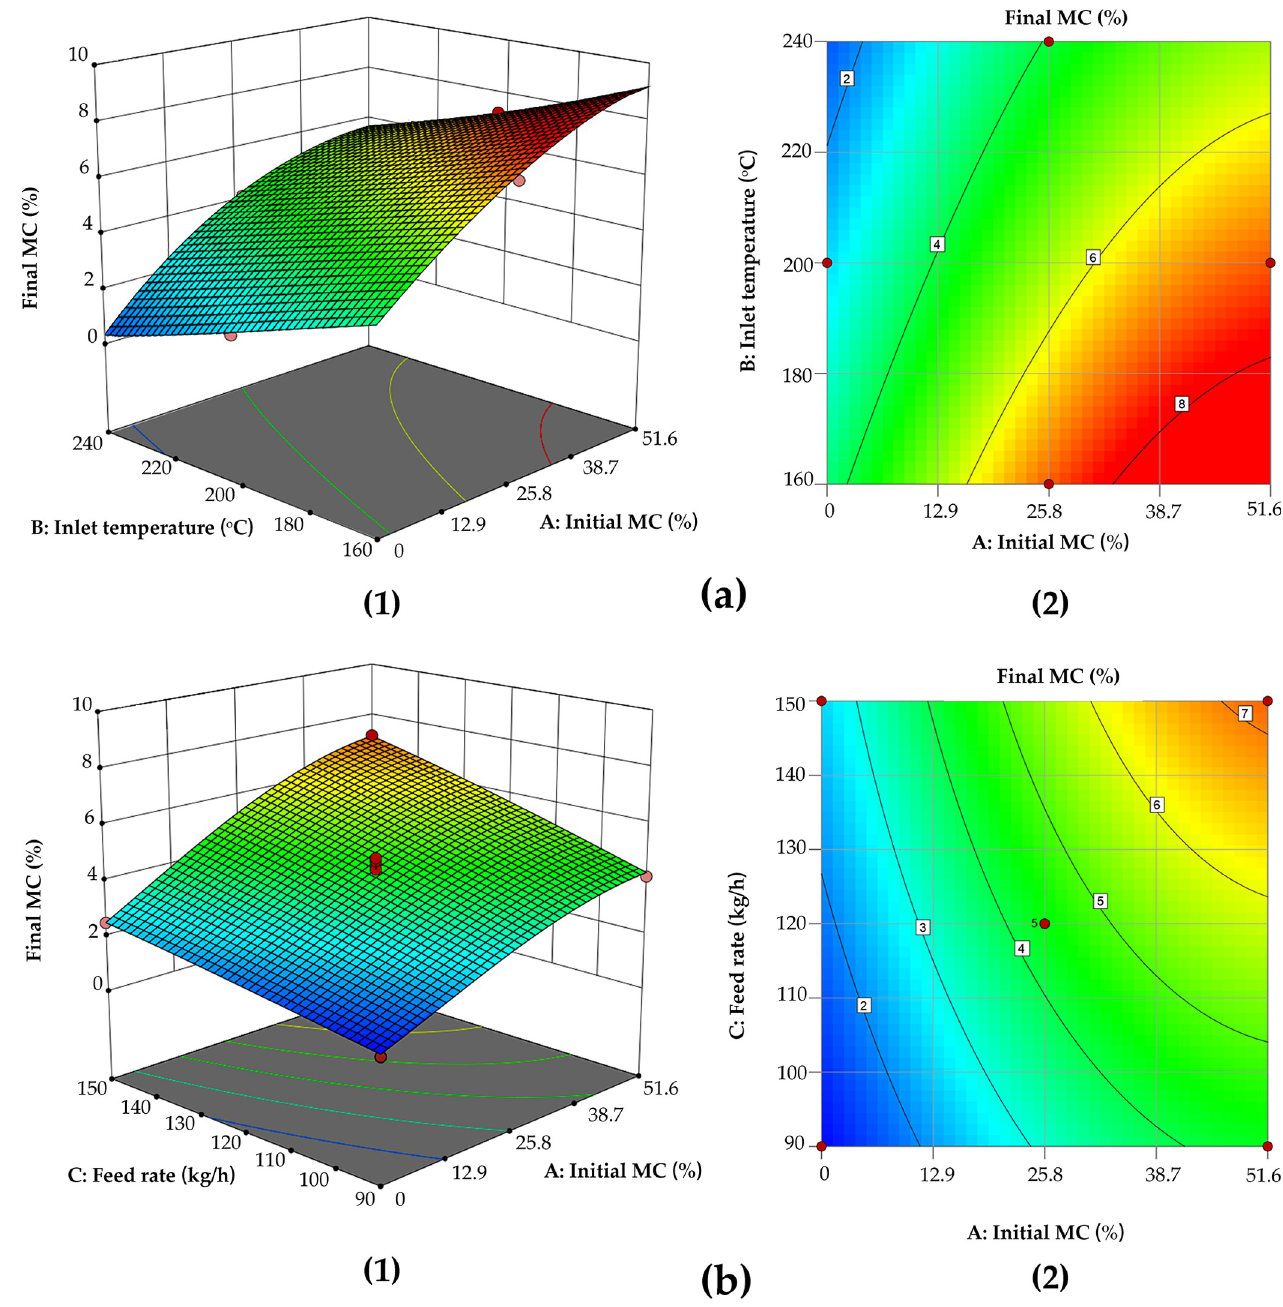
Fig 13. 3D Response surface (1) and contour map (2) concerning the interaction of experimental factors, (a) interaction between inlet air temperature and initial moisture content, (b) interaction between feed rate and initial moisture content. https://doi.org/10.1371/journal.pone.0266186.g013 The regression analysis of the final MC was carried out on the test sets of RSM, the BP neu- ral network model, and the LSTM. Fig 14 shows the comparative analysis on the experimental predicted values of the three models. The evaluation indexes of RSM, the BP model, and the LSTM model are obtained by calculation. The results are shown in Table 6.